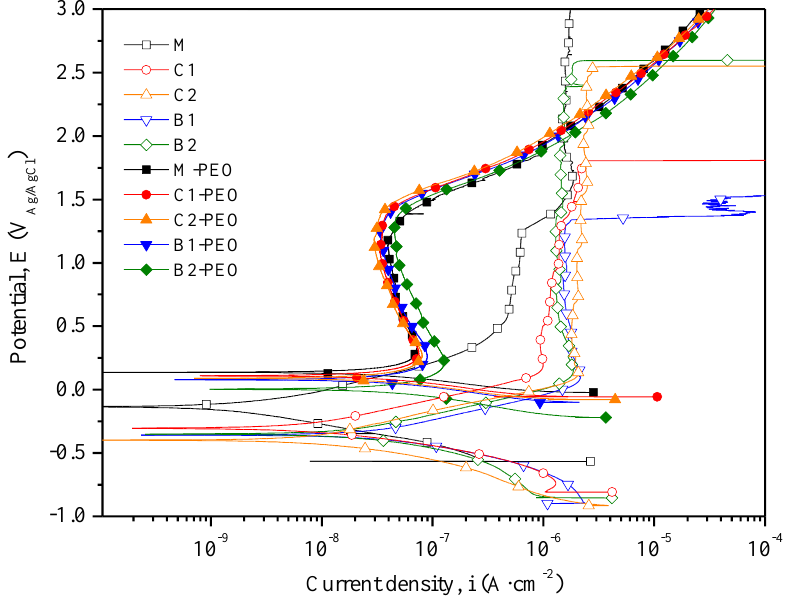
Figure 14. Potential vs. current density (E and i, respectively) during potentiodynamic polarization experiments of bare and PEO-treated samples in modified α -MEM solution. Table 7. Electrochemical parameters of non-treated and PEO-treated specimens. CR stands for corrosion rate and Rp for polarization resistance. * i pass values correspond to the density current at E pass .